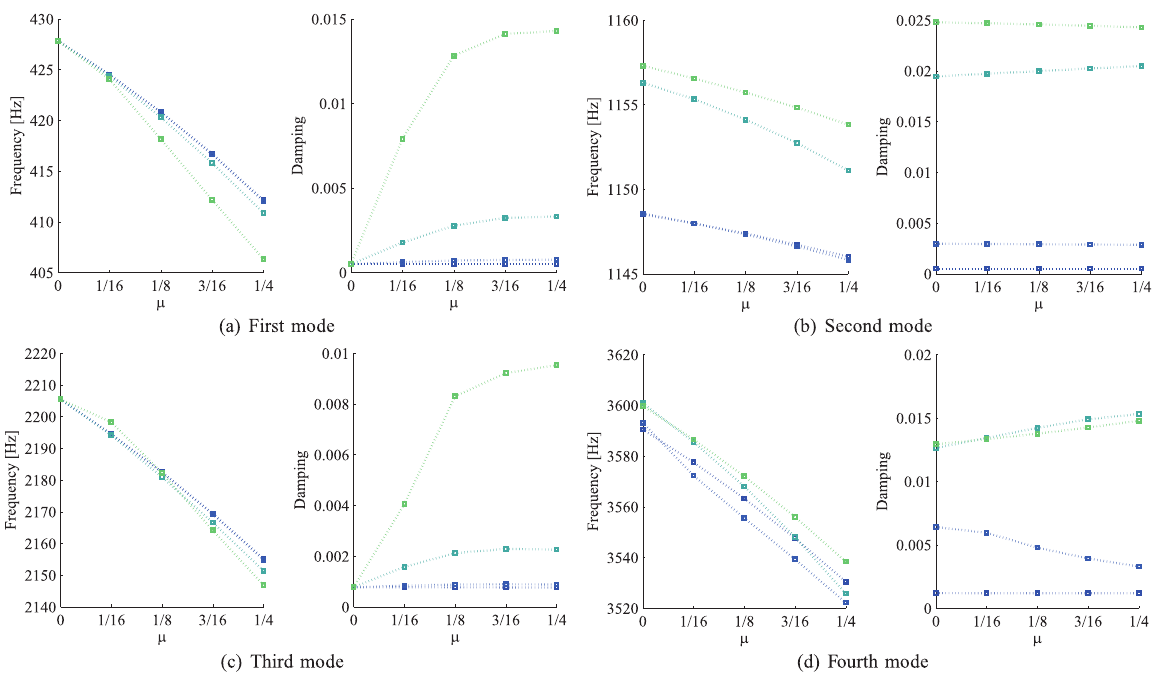
Fig. 6. Frequency and damping in the first case for three weighting matrices ( (cid:2) : uncontrolled, (cid:2) : Q 1 , (cid:2) : Q 2 , (cid:2) : Q 3 )